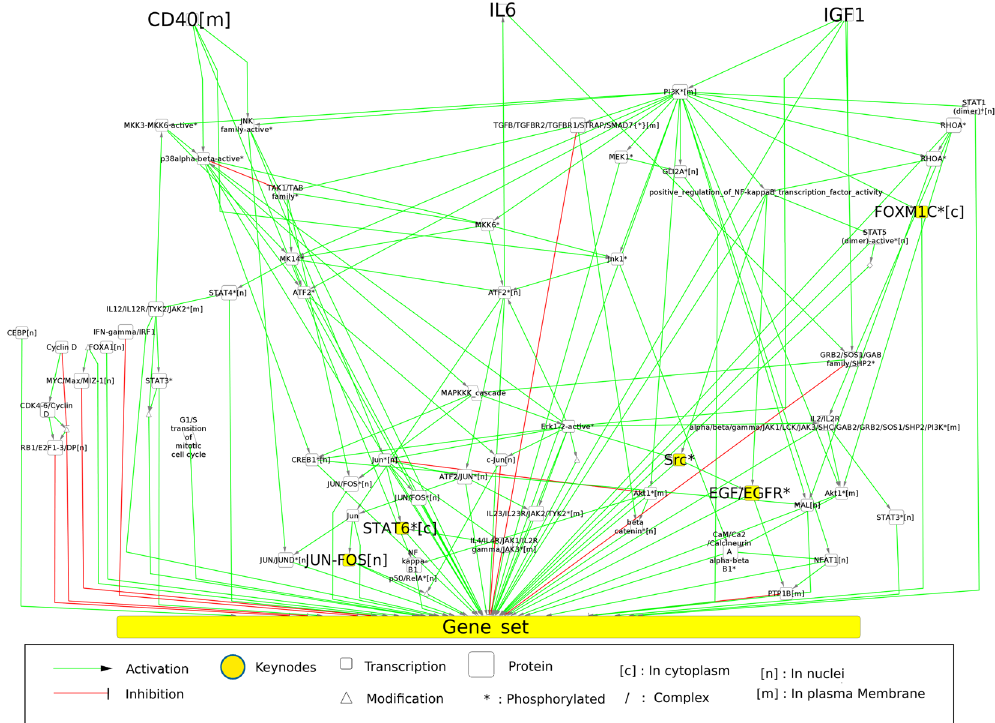
Figure 2. Representation of the subgraph obtained from the PID-NCI database. CD40, IL6 and IGF1 (the nodes in the top portion of the graph) are the 3 queried pathways. The 529 genes that are differentially expressed across all profiles are merged for this representation in the node “Gene set”. The 5 top-ranked nodes according to their FS are labeled in bold type and colored in yellow. We used the same syntax for all nodes in this study. The edges from the “Gene set” node to proteins have been deleted for the sake of clarity.